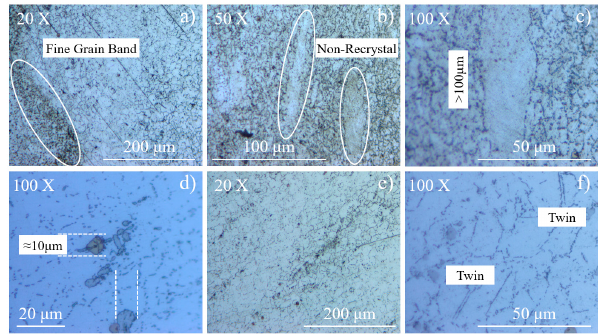
Figure 2. OM micrographs of annealed and aged Inconel 718: ( a – d ) annealed material, ( e , f ) aged material.